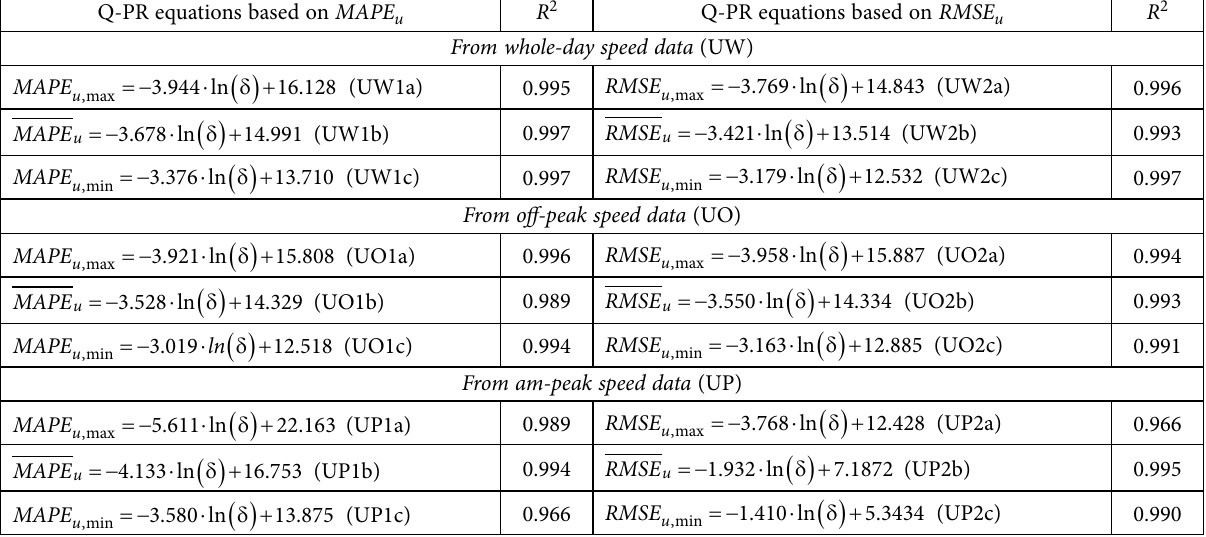
Table 4. Simulation-based on Q-PR relations Q-PR equations based on MAPE u